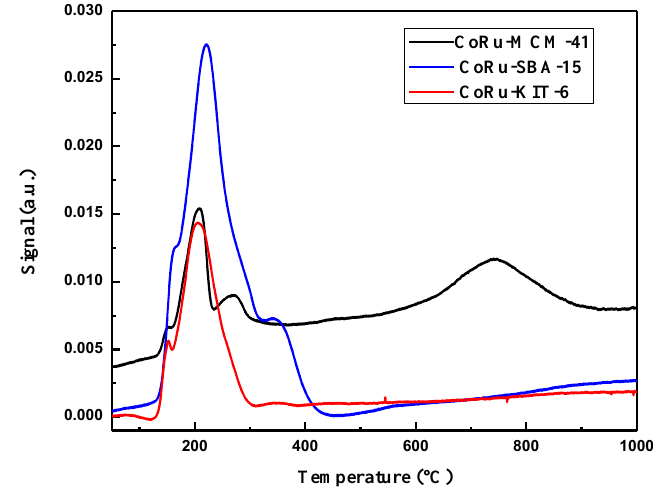
Figure 6. H 2 -TPR(temperature programmed reduction) profiles of CoRu-S (S = MCM-41, KIT-6 and SBA-15) Catalysts